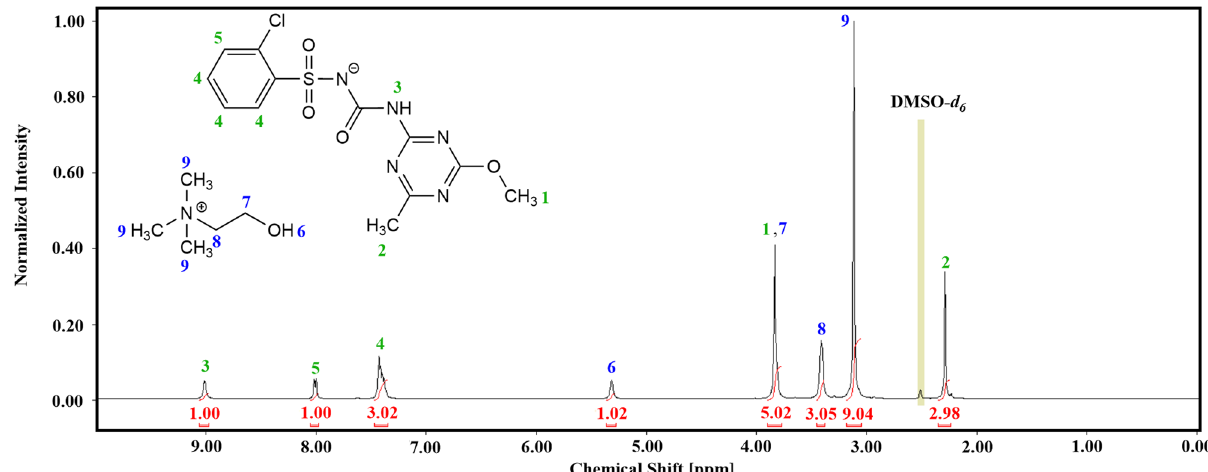
Figure 2: 1 H NMR spectrum of salt comprising cholinium cation and chlorsulfuron as the anion ( 4 ) .